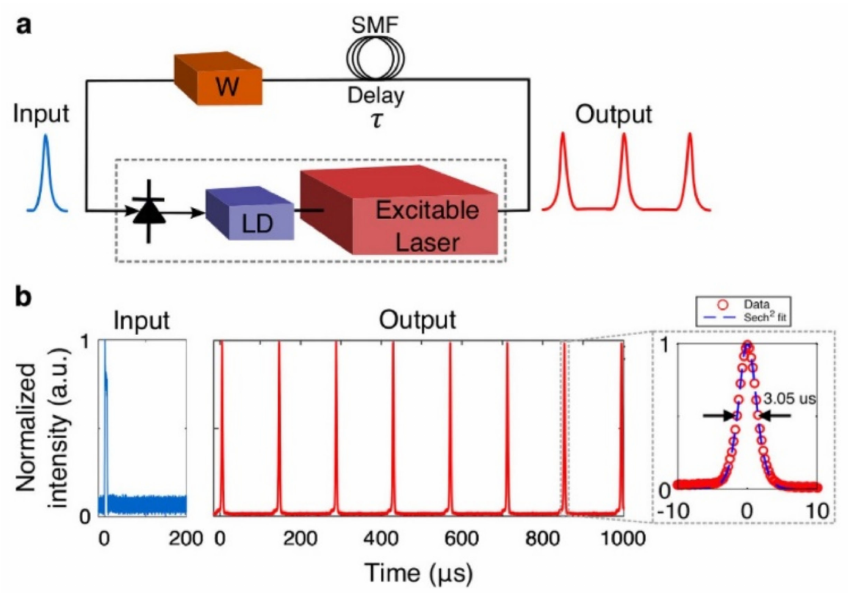
Figure 10. ( a ) The circuit for the creation of repeated current peak. ( b ) The waveforms of the implementation. One pulse of the output is led to the input via single-mode fiber (SMF), which acts as a delay element